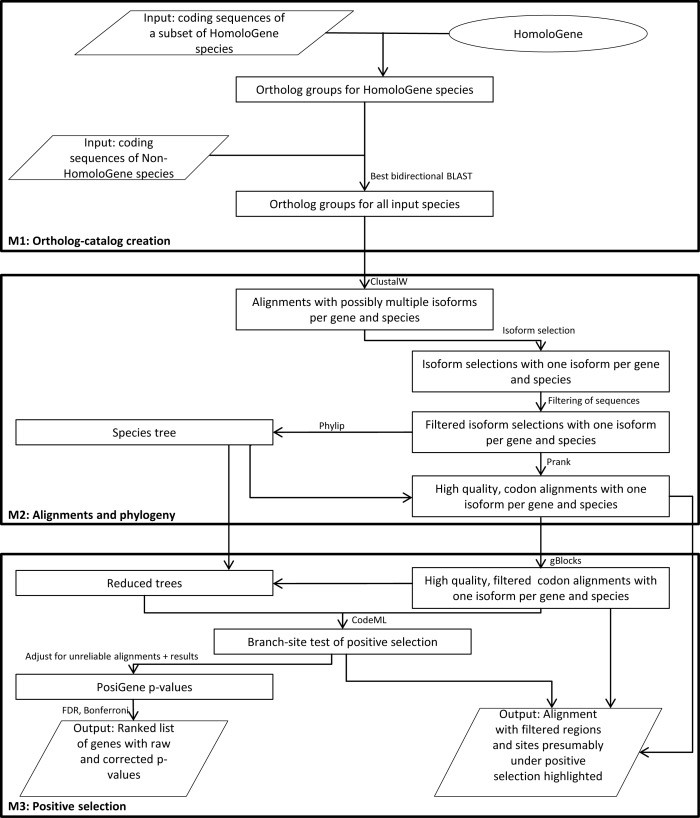
Workflow diagram of PosiGene.